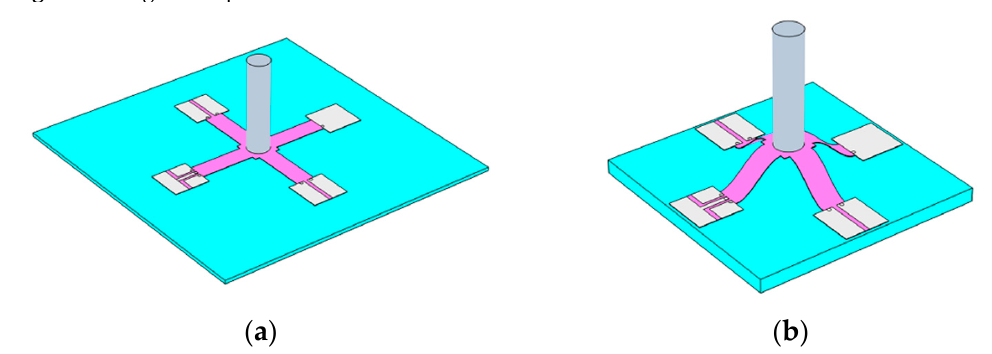
Figure 1. Diagram of piezoresistors on crossbeam.